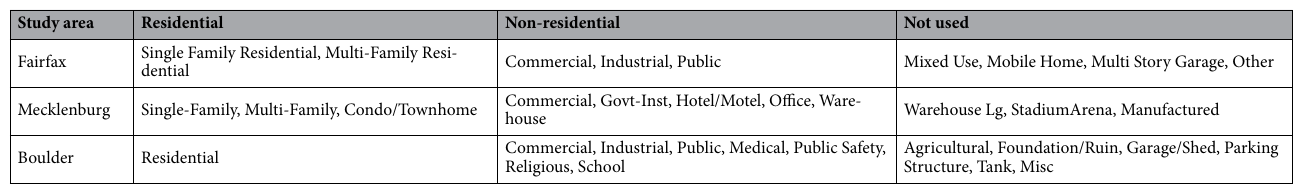
Table 4. Ground truth building type meta-categories for Fairfax, Mecklenburg, and City of